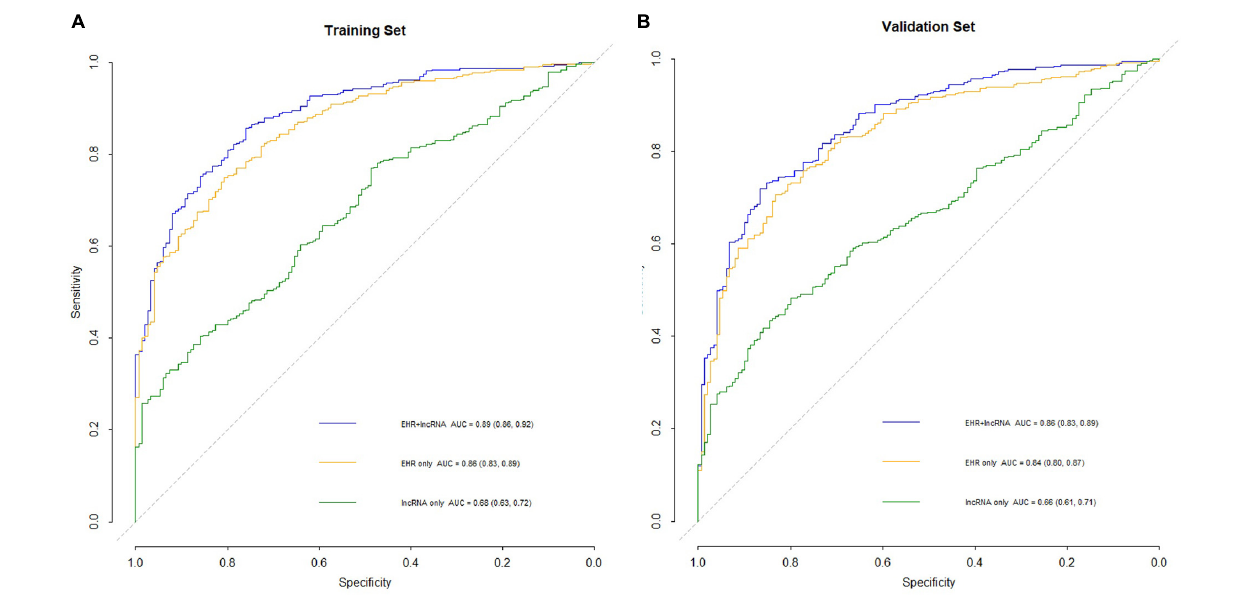
(Hb), weight loss (weight loss), night sweating (Night_sweat), imaging showing polymorphic changes